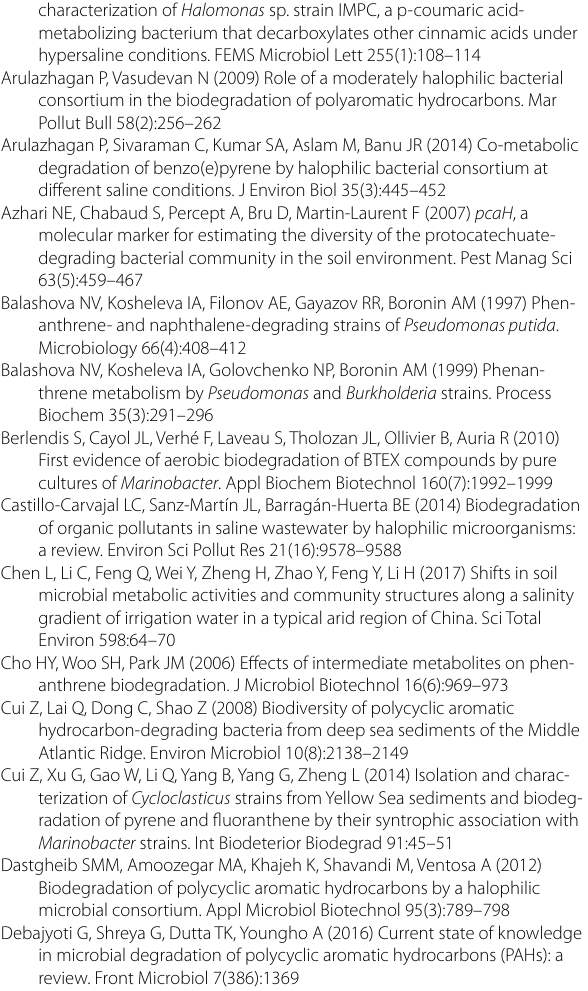
Additional file 1: Table S1. Accession numbers of the cloned catabolic gene sequences. Figure S1. Relative expression levels of genes encoding RHD, C12O, C23O, P34O, and G12O during phenanthrene degradation under different salinity. The transcript/gene ratios were calculated for the microcosm incubation. Three independent experiments were performed (error bars are not shown). A: Relative expression of genes encoding RHD; B: Relative expression of genes encoding C12O; C: Relative expression of genes encoding P34O; D: Relative expression of genes encoding C23O; E: Relative expression of genes encoding